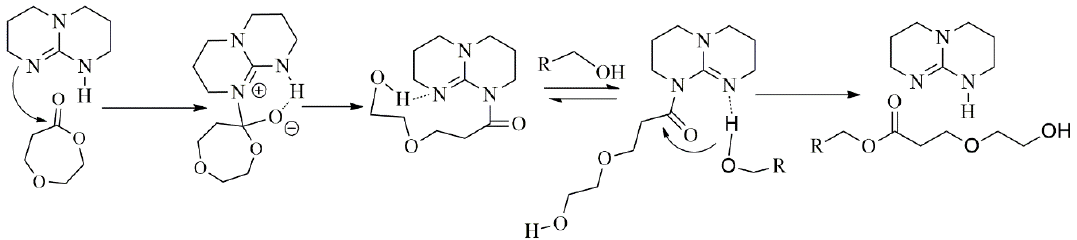
Scheme 4. Proposed nucleophilic mechanism for the ROP of DXO with TBD as the